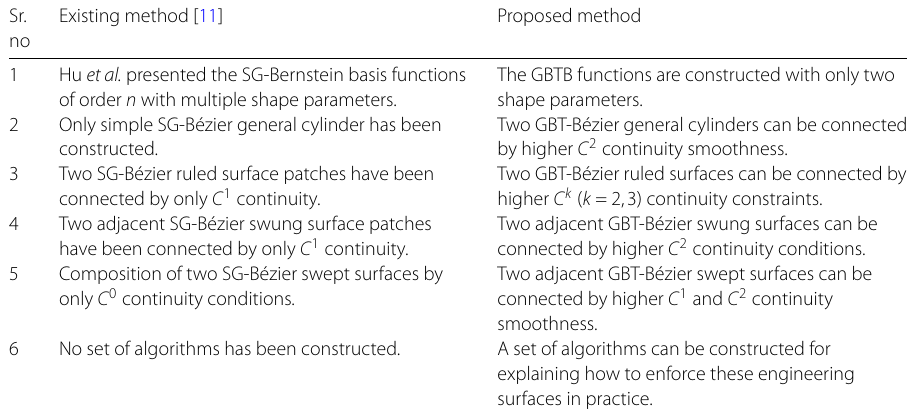
Table 1 Comparison of research